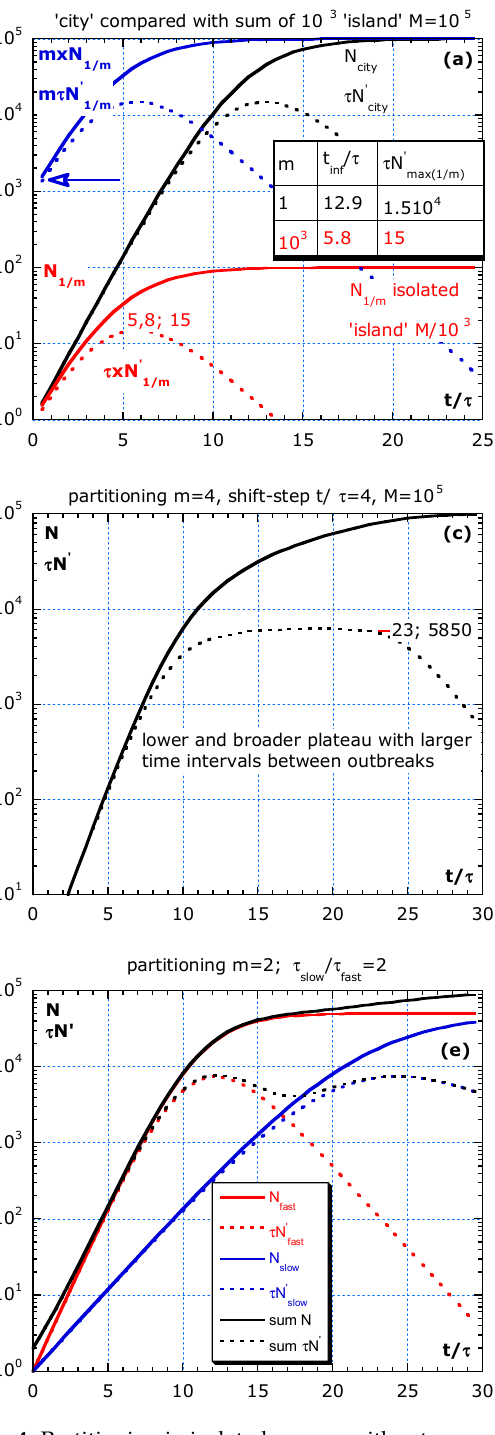
Figure 4. Partitioning in isolated groups without parameter change during the outbreak and its effect on 𝜏𝑁(cid:4662) ≡ 𝜏𝑁 (cid:4593) . ( a ) A large number of equal islands all starting at t = 0 results in a sum with high initial values (blue arrow) for N , 𝜏𝑁(cid:4662) and one peak in 𝑁(cid:4662) at t/ τ = 5.8. In ( b , c ), four isolated outbreaks are modelled at equidistant time lags. The outbreak intervals in ( b ) are t/ τ = 3 and in ( c ) are t/ τ = 4, and the result in a plateau, and ( d ) is the epidemic curves in a lin–lin plot as simulated in ( b , c ) by four patchy outbreaks at fixed time intervals. ( e ) A fast group isolated from a slow with equal size but with characteristic time τ and 2 τ results in a first and second peak. ( f ) Special case of partitioning ( m = 1) for comparing 0% with 75% of vaccination.